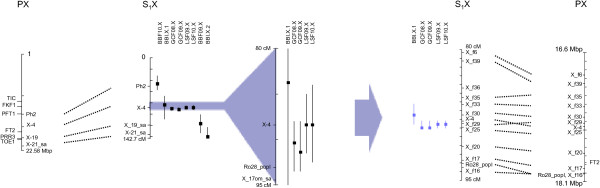
QTL hotspots on LG X for the mapped traits (BB = bud burst, GC = growth cessation and LS = leaf senescence) and alignment to the poplar (P. trichocarpa) physical map. Homologous markers are connected with dotted lines. The positions of candidate genes involved in the photoperiodic pathway and circadian clock are shown on the poplar chromosomes. The regions with increased marker density are shown to the right of the arrows.